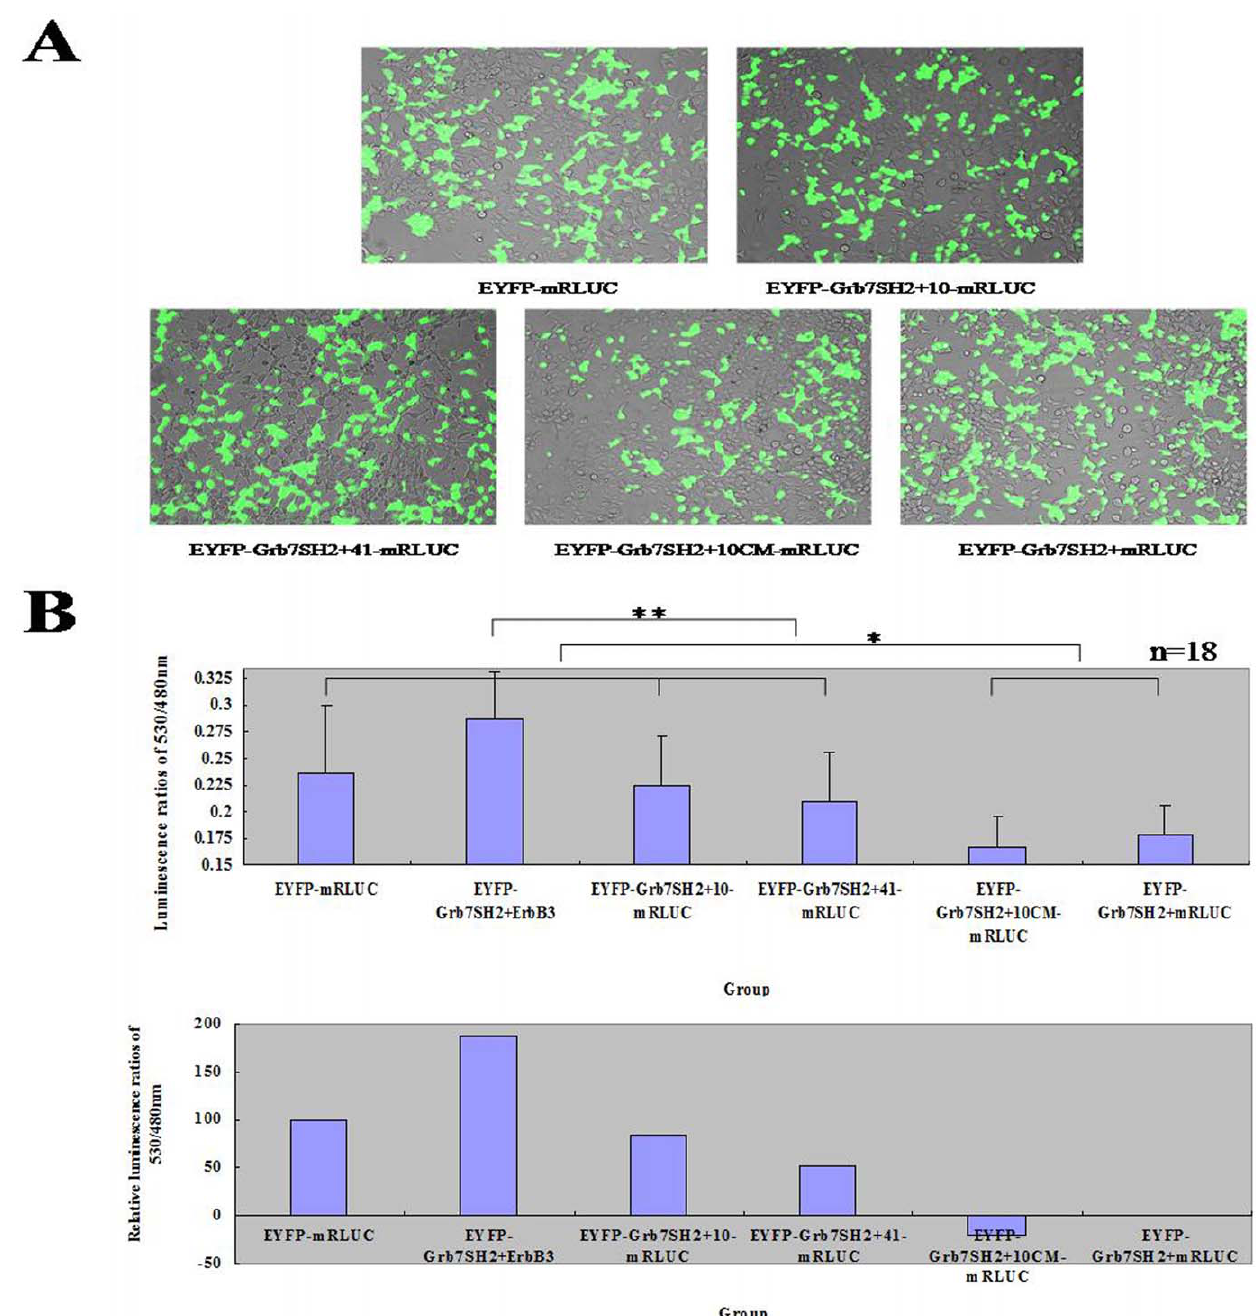
Figure 2. BRET assay of interactions between nonphosphorylated peptides and the Grb7 SH2 domain. A ) Overlaid images of transfected EYFP-fused proteins in living HEK293T cells at 480 nm. B ) Quantification of the BRET luminescence ratios. The direct luminescence ratios of 530/480 nm were on the top, and the relative luminescence ratios of 530/480 nm were on the bottom. The BRET reaction was initiated by the coelenterazine (5.9 m M). The statistical analysis was based on eighteen group ratios, * represented statistical significance with p , 0.05 and ** represented statistical significance with p , 0.01.